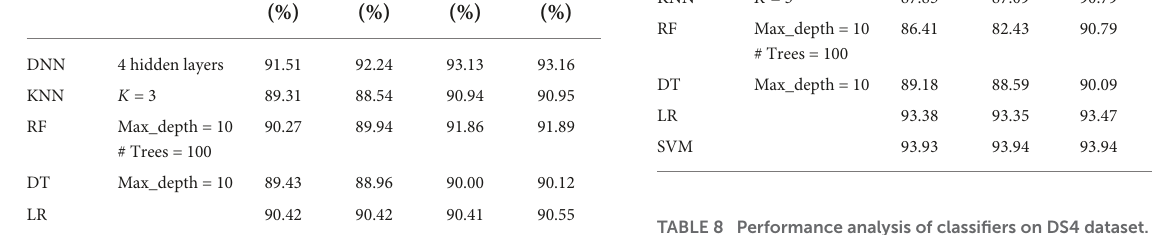
TABLE 8 Performance analysis of classifiers on DS4 dataset.